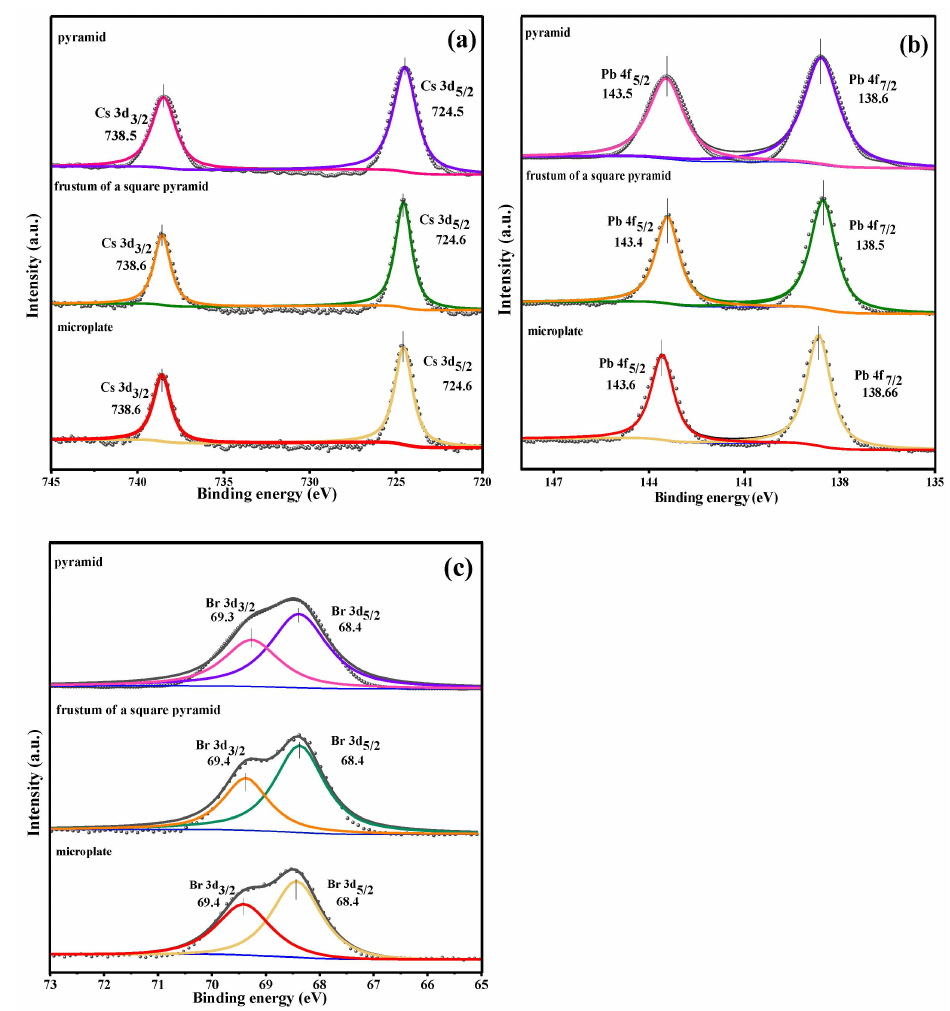
Figure 5. The XPS spectra of CsPbBr 3 microplate, frustum of a square pyramid, and pyramid for Cs 3d ( a ), Pb 4f ( b ), and Br 3d ( c